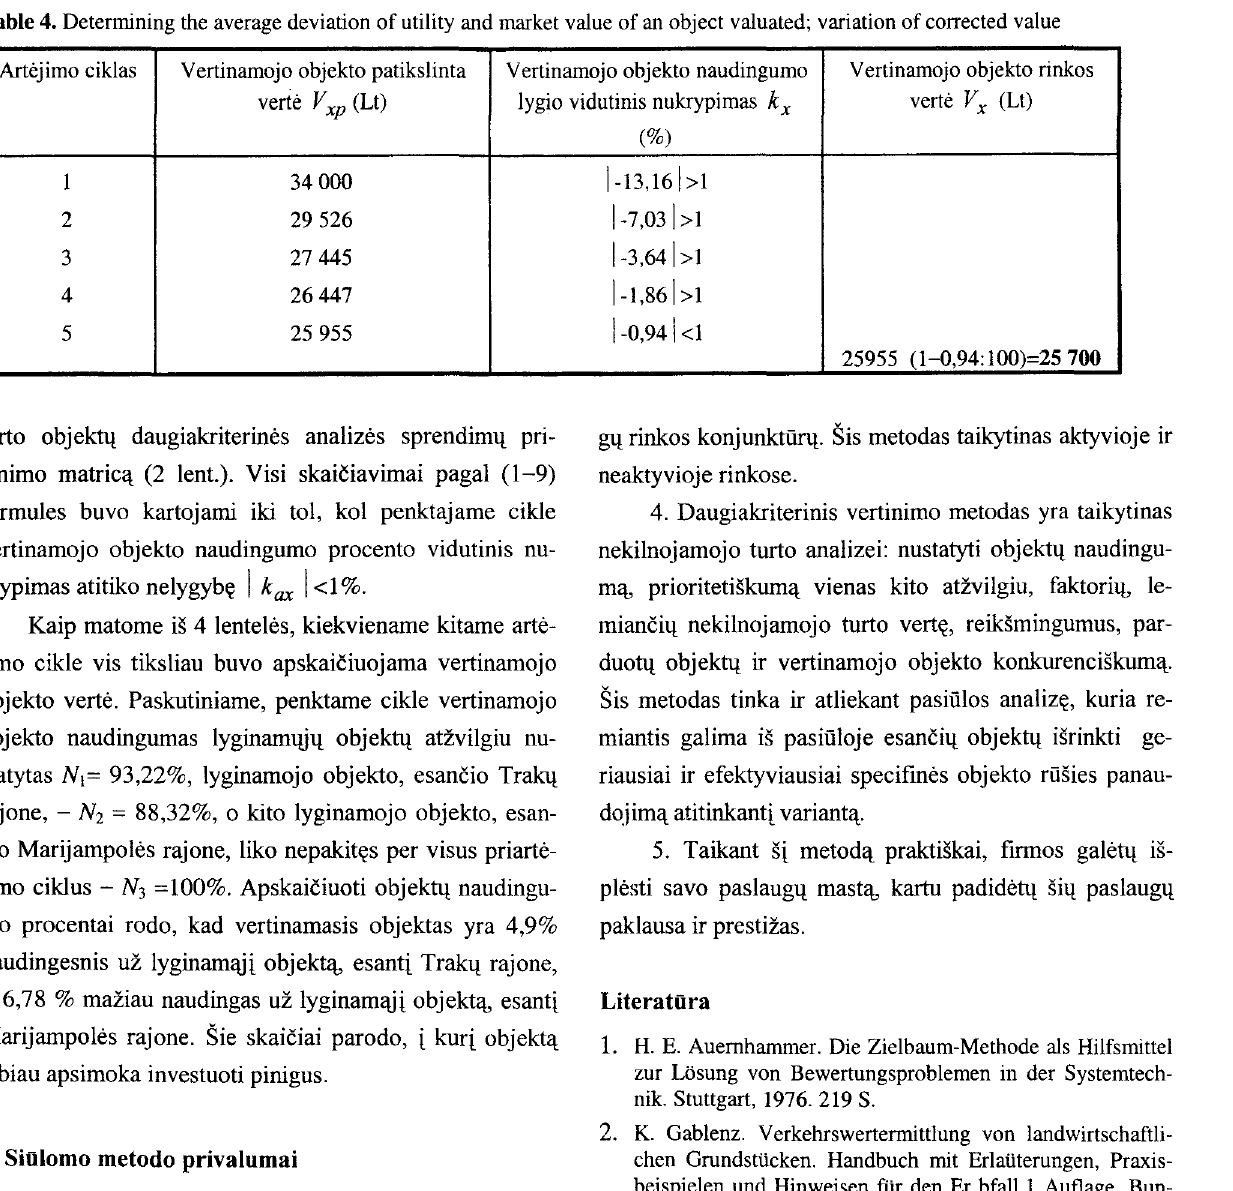
Table 4. Determining the average deviation of utility and market value of an object valuated; variation of corrected value ArU:jimo